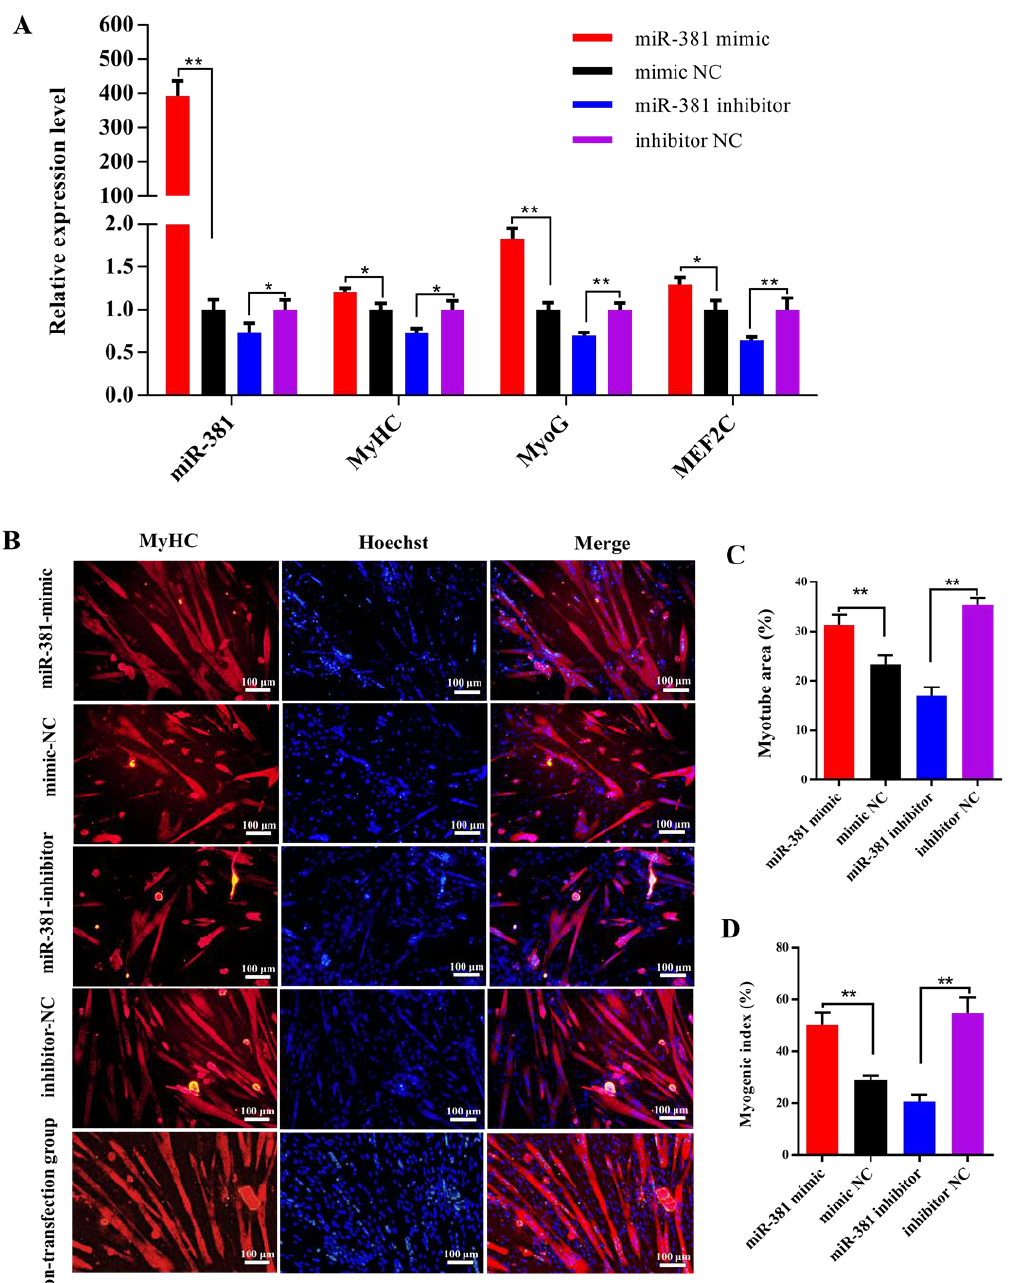
Figure 2. The miR-381 promoted differentiation of caprine skeletal muscle satellite cells (SMSCs). ( A ) Expression levels of miR-381 and myogenic differentiation marker genes MyHC , MyoG and MEF2C in differentiated caprine SMSCs transfected with miR-381 mimic, miR-381 inhibitor and their corresponding negative control (NC) groups. ( B ) The effect of miR-381 on the formation of MyHC-positive myotubes detected by anti-MyHC immunofluorescence staining. Relative myotube area ( C ) and myogenic index ( D ) of differentiated caprine SMSCs counted by ImageJ software v1.8.0 (NIH, Bethesda, MD, USA). * p < 0.05 and ** p <